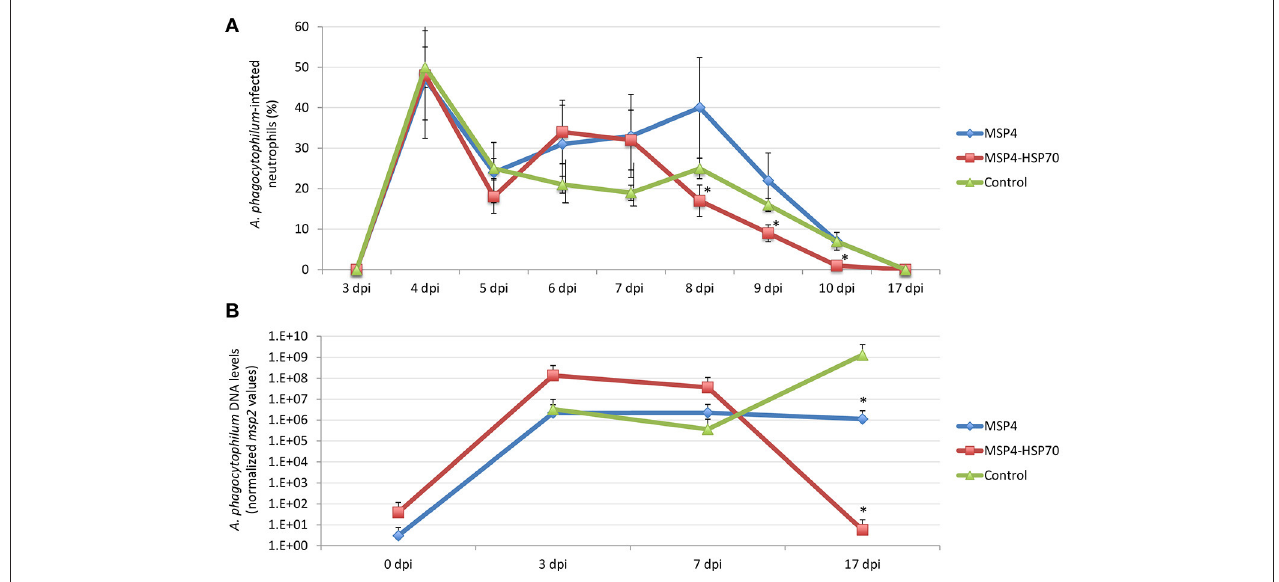
FIGURE 5 | Anaplasma phagocytophilum infection levels in immunized and control lambs. (A) Blood smears stained with Giemsa stain were examined to investigate the presence of A. phagocytophilum in blood cells. At least 100 neutrophils were counted and examined to calculate the number of infected neutrophils per milliliter blood of each lamb. The differential percent of A. phagocytophilum -infected neutrophils was calculated as the difference between values at different dpi and values at 3 dpi when infected neutrophils were first detected. The results were compared between immunized and control groups by two-way ANOVA test (* P < 0.05; N = 3 replicates per treatment). (B) For the quantitative analysis of A. phagocytophilum infection levels, a quatitative real-time PCR was conducted. The A. phagocytophilum DNA levels were normalized against sheep aldolase B using the genNorm method (ddCT method as implemented by Bio-Rad iQ5 Standard Edition, Version 2.0). Normalized Ct values were compared between immunized and control groups by Student’s t -test with unequal variance (* P < 0.05; N = 3 replicates per treatment).